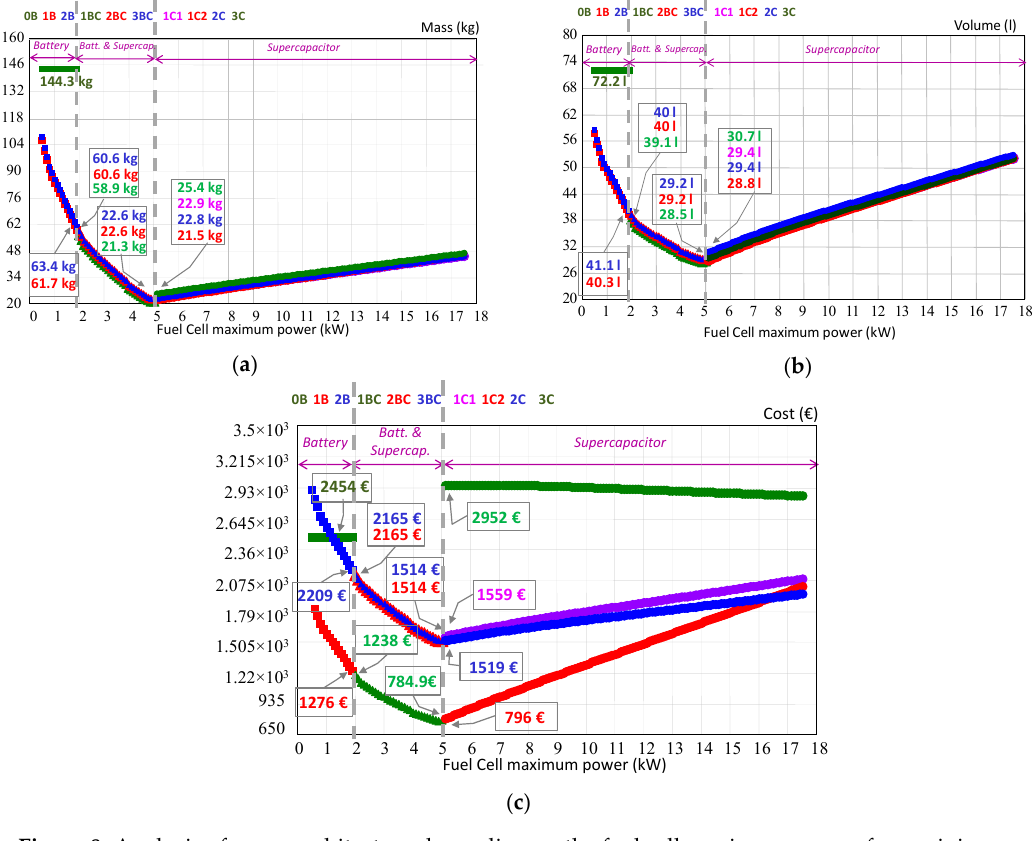
Figure 8. Analysis of every architecture depending on the fuel cell maximum power for a minimum fuel cell power of 400 W. ( a ) Mass. ( b ) Volume. ( c ) Cost.